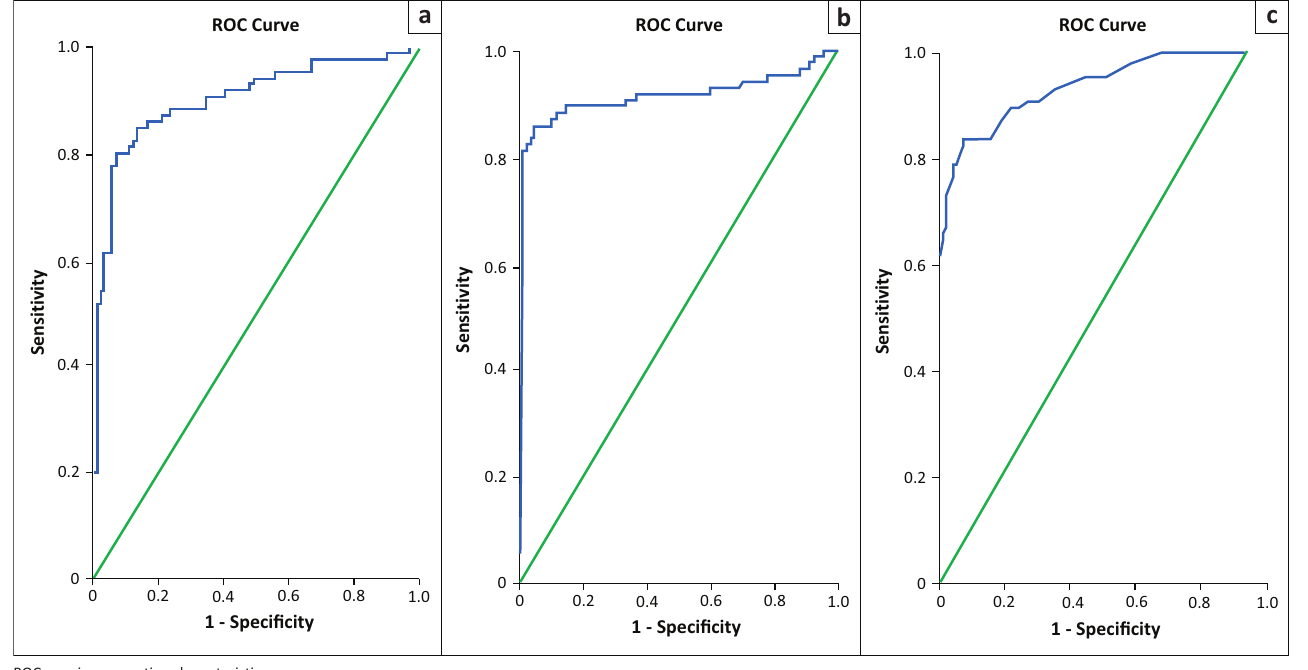
FIGURE 4: Receiver operating characteristic curve for (a) shear wave velocity, (b) distance ratio and (c) area ratio.